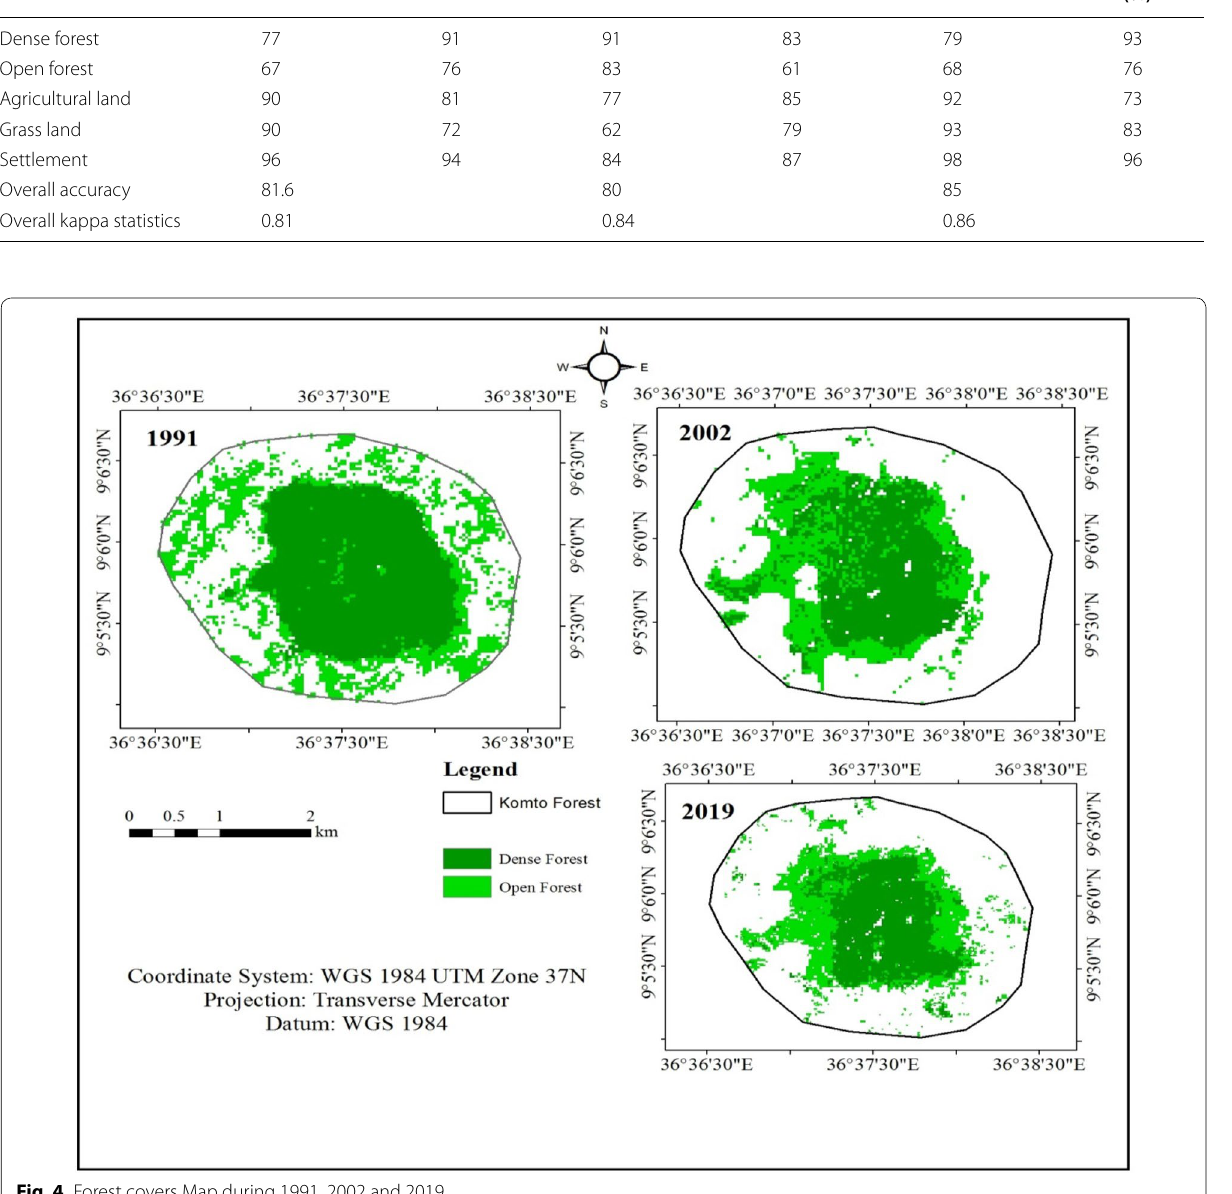
Fig. 4 Forest covers Map during 1991, 2002 and